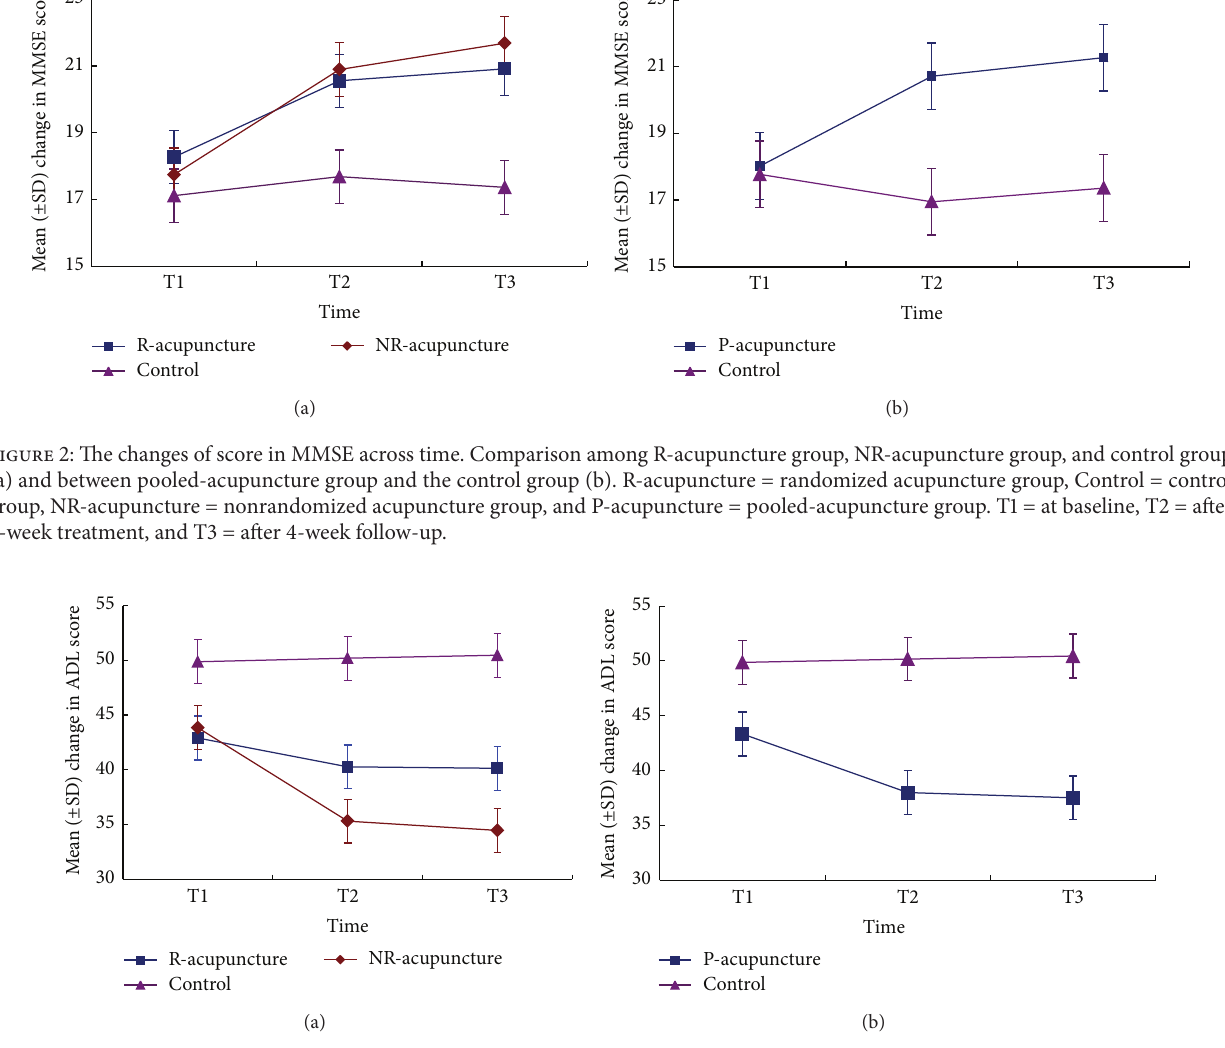
Figure 3: The changes of score in ADL across time. Comparison among R-acupuncture group, NR-acupuncture group, and control group (a) and between pooled-acupuncture group and the control group (b). R-acupuncture = randomized acupuncture group, Control = control group, NR-acupuncture = nonrandomized acupuncture group, P-acupuncture = pooled-acupuncture group. T1 = at baseline, T2 = after 6- week treatment, and T3 = after 4-week